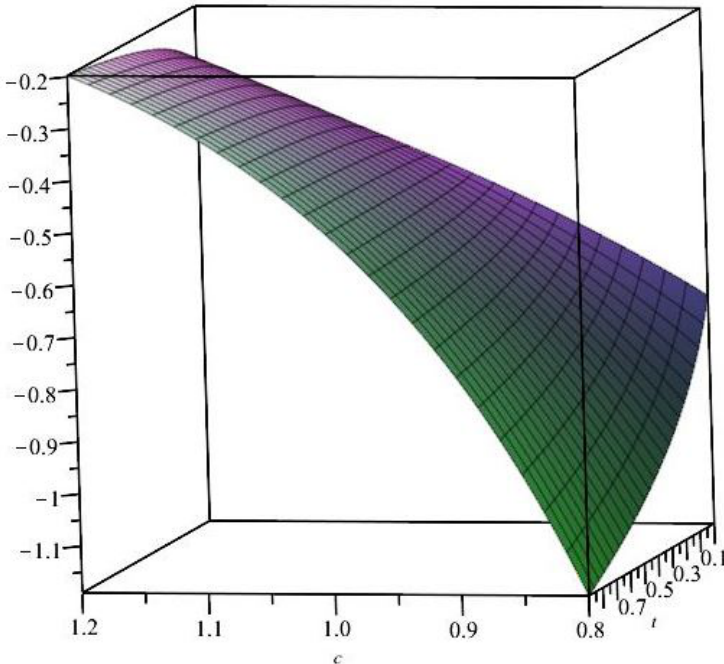
Figure 2. The variation of S { c } w.r.t. c ∈ ( 0.8,1.2 ) and θ 2 : = t